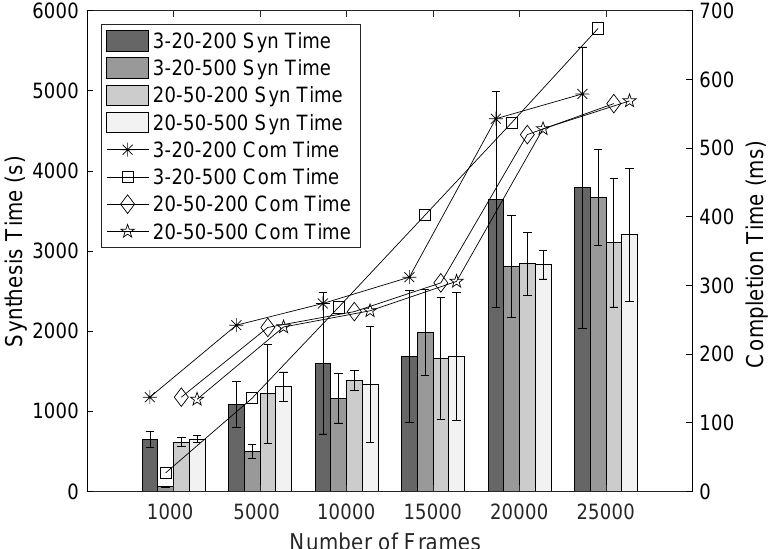
Figure 8. Synthesis time in seconds and schedule quality for different variable segments in the actual LU